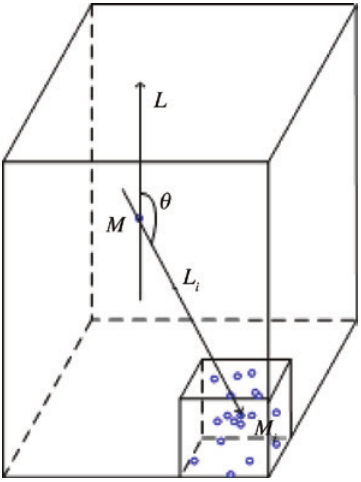
Figure 3: Angle Feature of a Subspace.